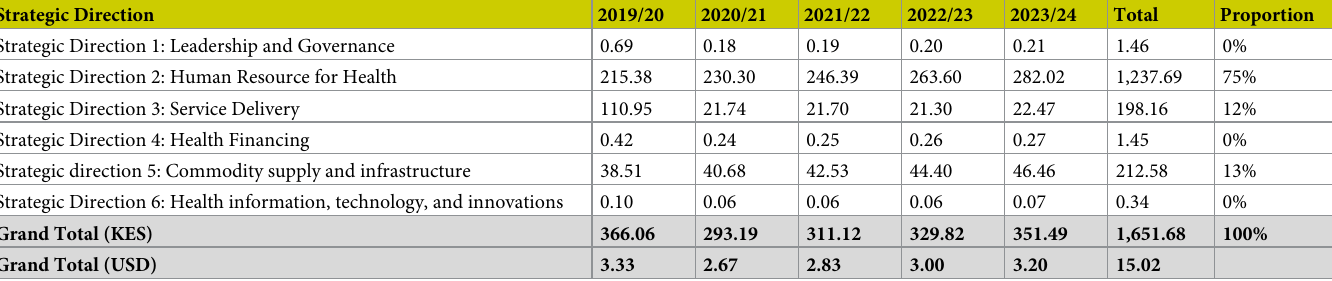
Table 1. Projected resource need for PHC framework by strategic areas (Ksh. Billion). Strategic Direction